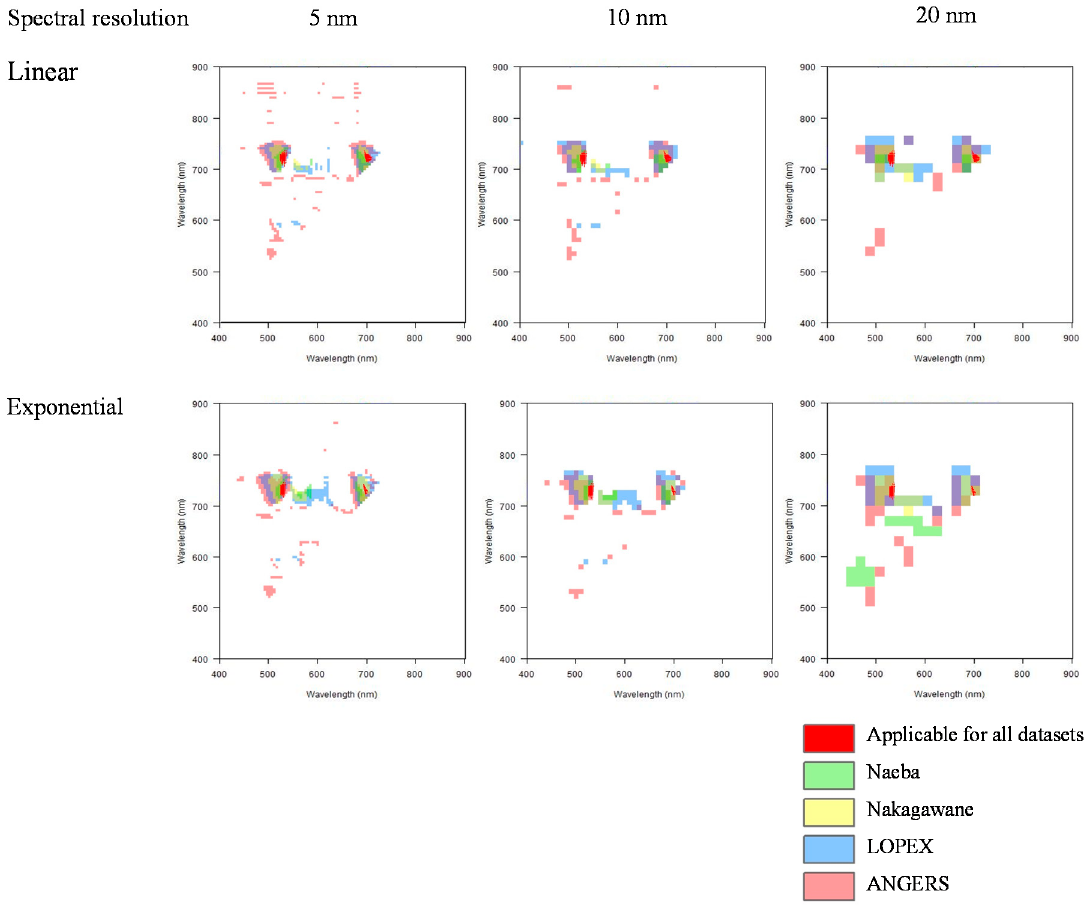
Figure 8. RPD changes with resolution down. Colored areas represent useful combinations for quantifying chlorophyll concentrations for each dataset (categorized ‘A’ or ‘B’ based on RPD values).